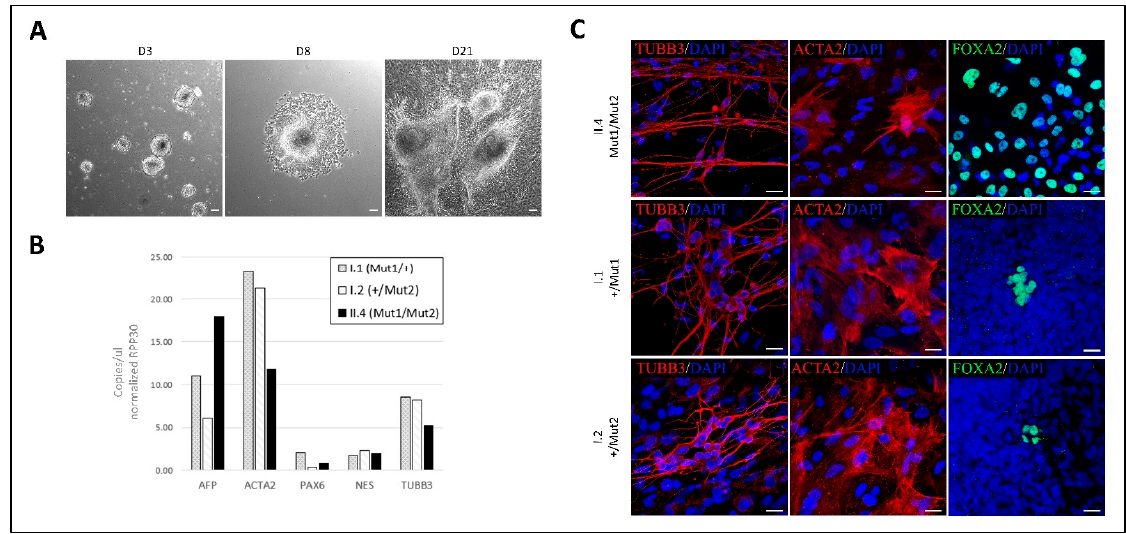
Figure 3. EBs formation assay performed on family-derived iPSCs. ( A ) Representative phase mi- croscopy pictures of three different stages of EBs generation. At day 3 EBs are forming in suspen- sion, at day 7 they are plated in adhesion and allowed to spontaneously differentiate towards the three germ layer derivatives until day 21 when they are processed for downstream analyses. Scale bar 100 μ m. ( B ) Droplet digital PCR quantification of ectodermal ( PAX6 , NES , TUBB3 ), mesodermal ( ACTA2 ) and endodermal ( AFP ) genes mRNA levels. Concentration is expressed as copies/ μ L and is normalized with the housekeeping gene RPP30 . Data from one biological replicate. ( C ) Immuno- fluorescence staining showing the presence of cells expressing specific markers belonging to ecto- derm ( TUBB3 ) (red), mesoderm ( ACTA2 ) (red) and endoderm ( FOXA2 ) (green) lineage. Scale bar 20 μ m. I.1 = father; I.2 = mother; II.4 = patient.